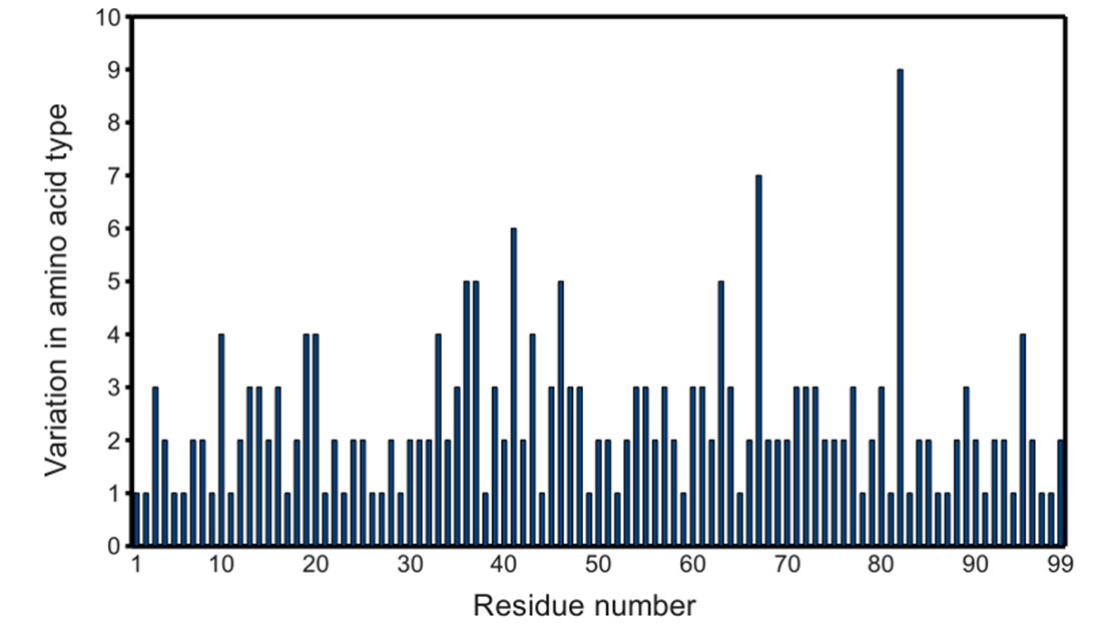
Figure 2. Variability of PR primary structures in the PDB. Graph considers the 811 PR monomers obtained as described in the experimental section, except PDB ID 2rkg, which contains an insertion. Non-standard residues (e.g., norleucine) are also